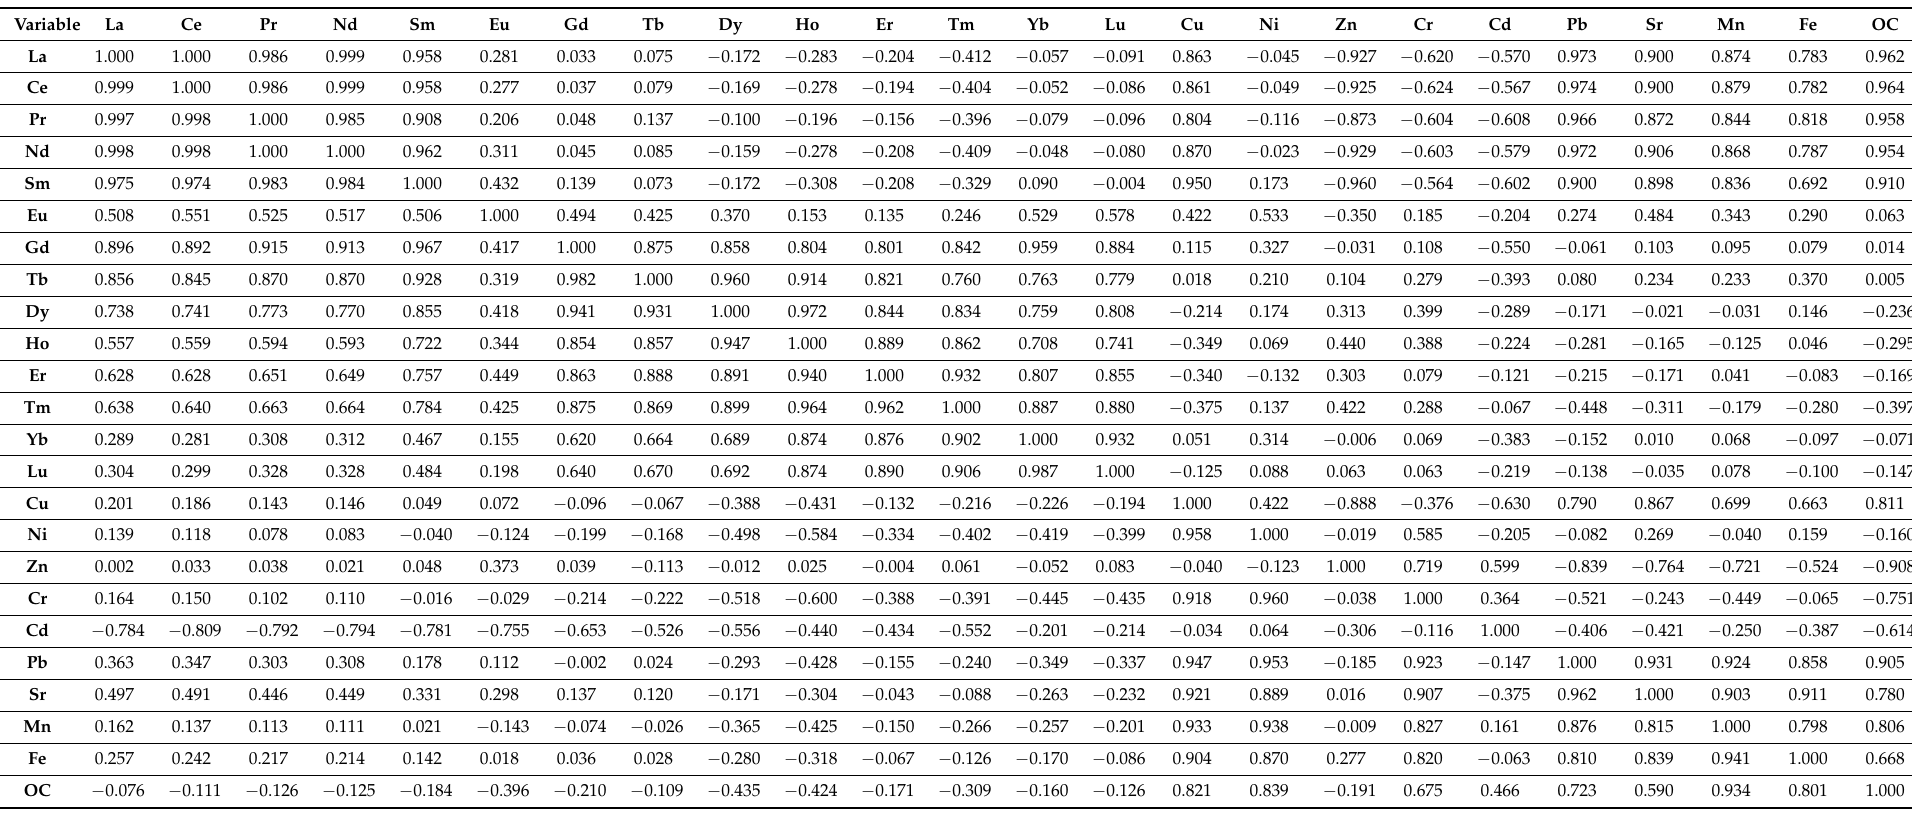
Table 7. Matrix of Pearson correlation coefficients for BS of lakes Ilma (lower triangle on the left) and Lovozero, Sergevan River (upper triangle on the